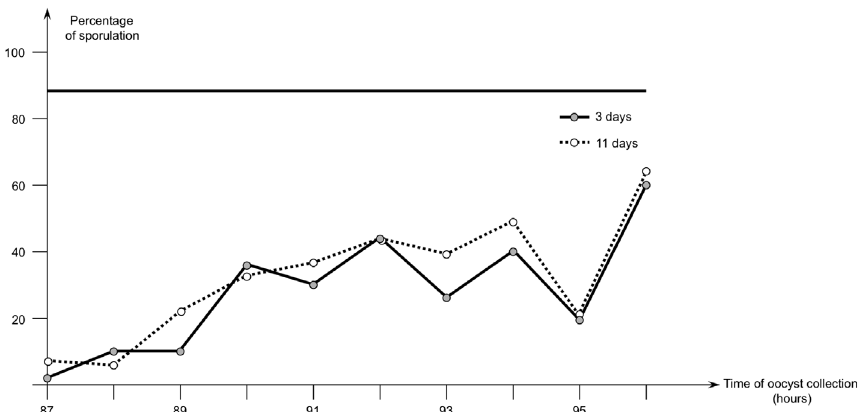
Figure 3. First study with Eimeria acervulina – evolution of the percentage of sporulation of oocysts of E. acervulina (PA3 strain) collected in the duodenum from 87 to 96 h after infection. Percentage of sporulation was evaluated after 3 and 11 days of incubation at 28 (cid:3) C. The horizontal straight line shows percentage of sporulation as observed in oocysts collected from droppings after 3 days of incubation at 28 (cid:3) C.